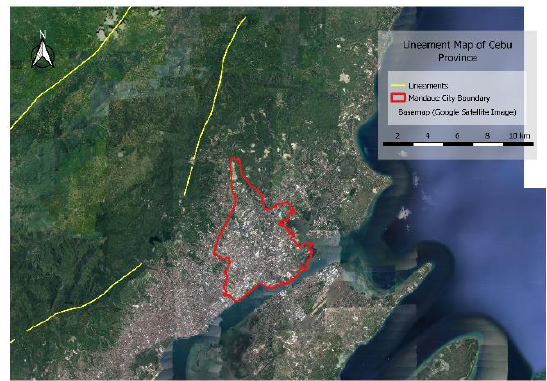
Figure 3. Lineaments near Mandaue City